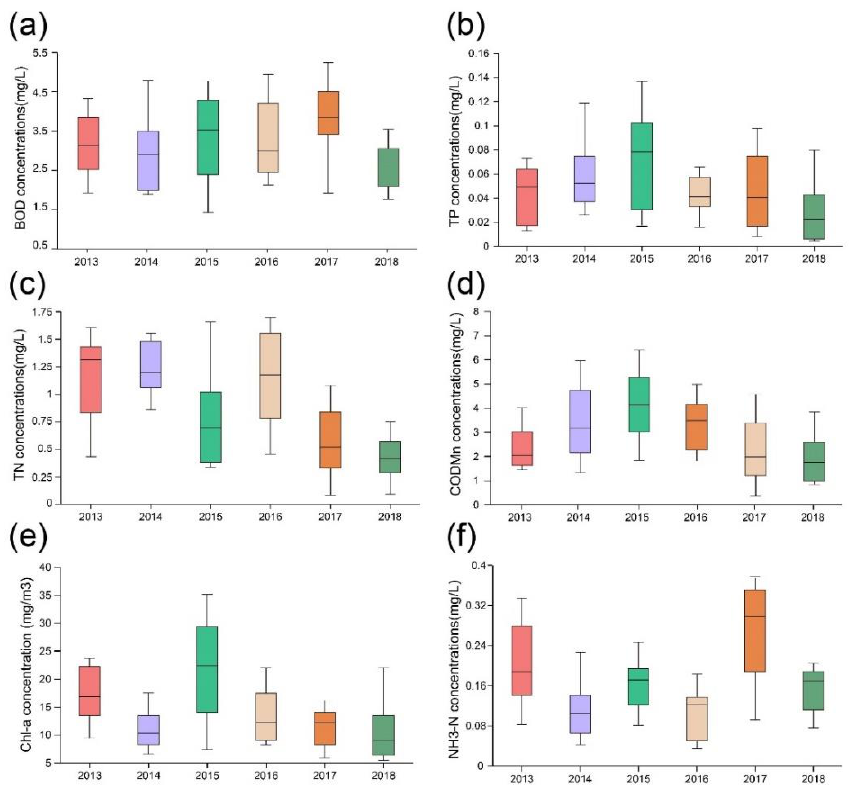
Figure 6. Box plots for averaged water quality parameters estimated by ConvLSTM model for Dongping Lake from 2013 to 2018: ( a ) BOD in mg/L, ( b ) TP, ( c ) TN in mg/L, ( d ) CODMn in mg/L, ( e ) Chl in mg/m 3 in mg/L and ( f ) NH3-N in mg/L. The midline of the box indicates the median; bottom and top of the box represent upper and lower quartiles, respectively and the bottom and top whiskers represent 10th and 90th percentiles, respectively.